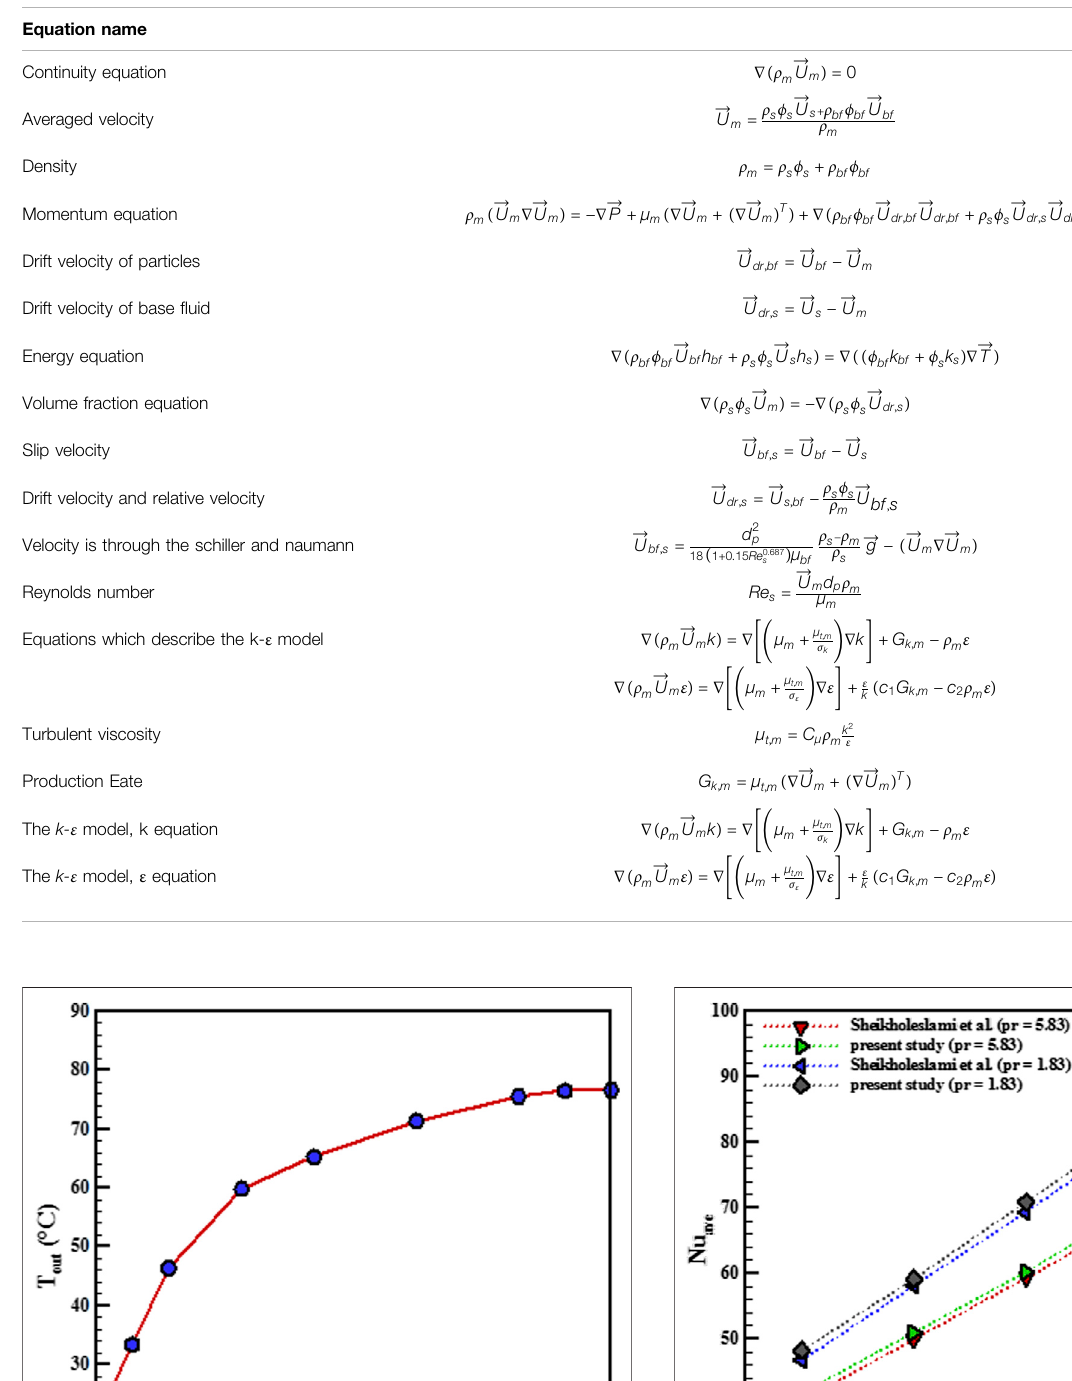
TABLE 3 | Governing equations (Sheikholeslami et al., 2016).